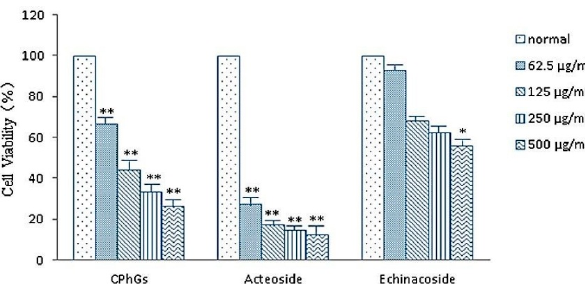
Figure 2. CPhGs, echinacoside and acteoside decreased the viability of HSC-T6. Cells were treated with DMEM (normal) or the indicated concentrations of CPhGs, echinacoside and acteoside for 48 h. Data were expressed as mean ± SD. n = 4. * p < 0.05, ** p < 0.01 compared with normal group.